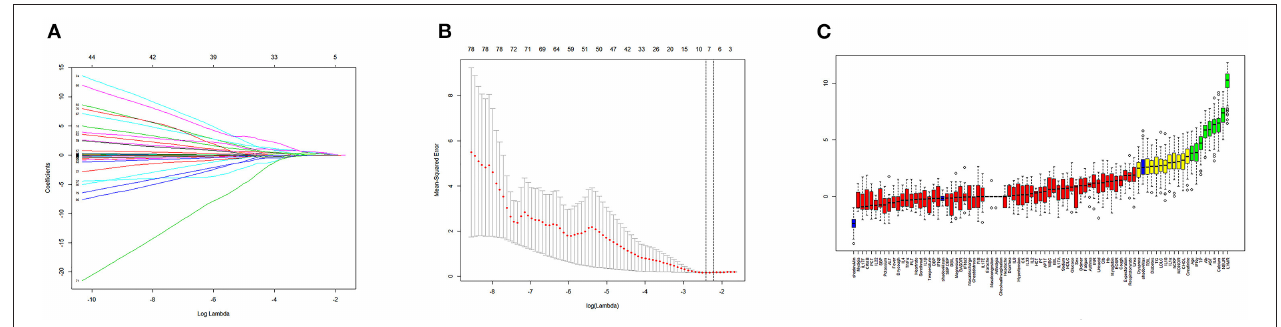
FIGURE 2 | (A) Coefficient diagram of least absolute shrinkage and selection operator (LASSO) variables. Each curve in the figure represents the trajectory of the coefficient of an independent variable. The ordinate represents the value of the coefficient. The lower abscissa, λ , is a parameter that controls the severity of the penalty. The upper abscissa represents the number of non-zero coefficients in the model under the penalty parameter. (B) Adjustment parameters in the LASSO model; λ was screened by 10-fold cross-validation. A dashed vertical line was drawn at one standard error (1–SE standard) of the minimum and minimum standards. 3 0.1 se corresponds to a model with good performance but the fewest number of arguments. (C) A variable importance plot according to Boruta feature selection. Blue boxplots correspond to minimal, average, and maximum Z scores of a shadow attribute. The Z-score clearly separates important and non-important attributes. Red, yellow, and green colors represent rejected, suggestive, and confirmed attributes by Boruta selection, respectively.